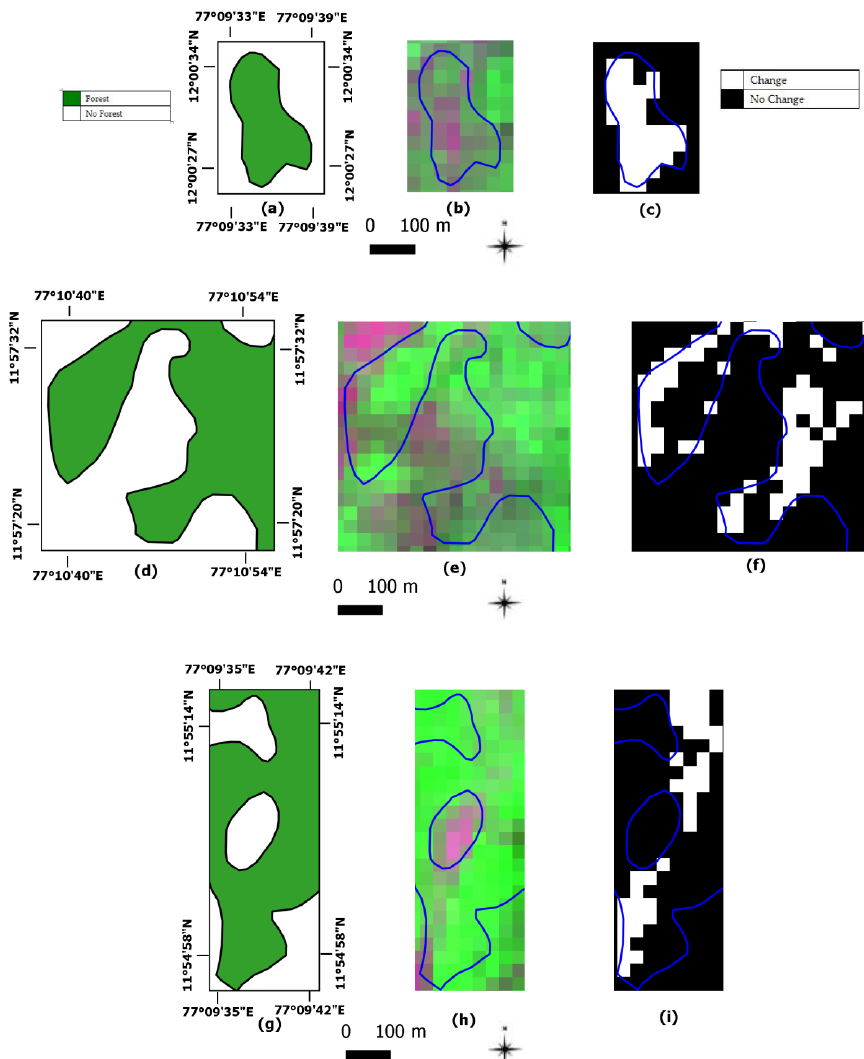
Figure 12 Figure 12. Experiment 2.a—CCA_HR close-up areas from Figure 11 , Indian site: ( a – c ) close-up areas in Figure 11c, red circle, where the new road in the evergreen forest area (in the blue polygon overlaid on the images) is clearly visible; ( d – f ) close-ups in Figure 11c, blue circle, where forest degradation or community change may have occurred at T 2 ; and ( g – i ) close ups in Figure 11c, yellow